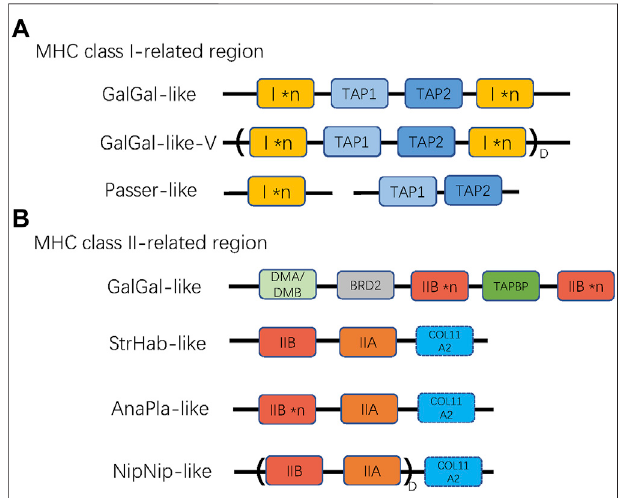
FIGURE 2 | The patterns of gene arrangement in (A) MHC class I-related,and (B) classII-relatedregions.* n indicatescopynumbervariationof a single gene (MHC-I or MHC-IIB), while D with parentheses indicates duplication of a linked region. For MHC-I region, GalGal-like-V variant indicates duplicated (I × n ~ TAP1~TAP2~I × n ) unit, and Passer-like pattern indicates lack of linkage between TAPs and MHC-I genes. For MHC-II